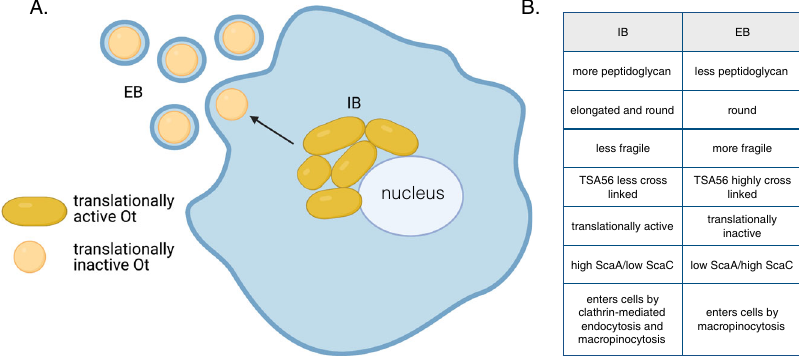
Fig. 7 An overview of the infection cycle of Ot, showing differentiation between IB and EB forms. A IB replicate in a micro-colony adjacent to the nucleus where they are elongated in shape and translationally active. Bacteria move to the cell ’ s edge and transition to an EB form that is round and translationally inactive. Created with BioRender.com. B Table summarizing the differences between IB and EB forms of